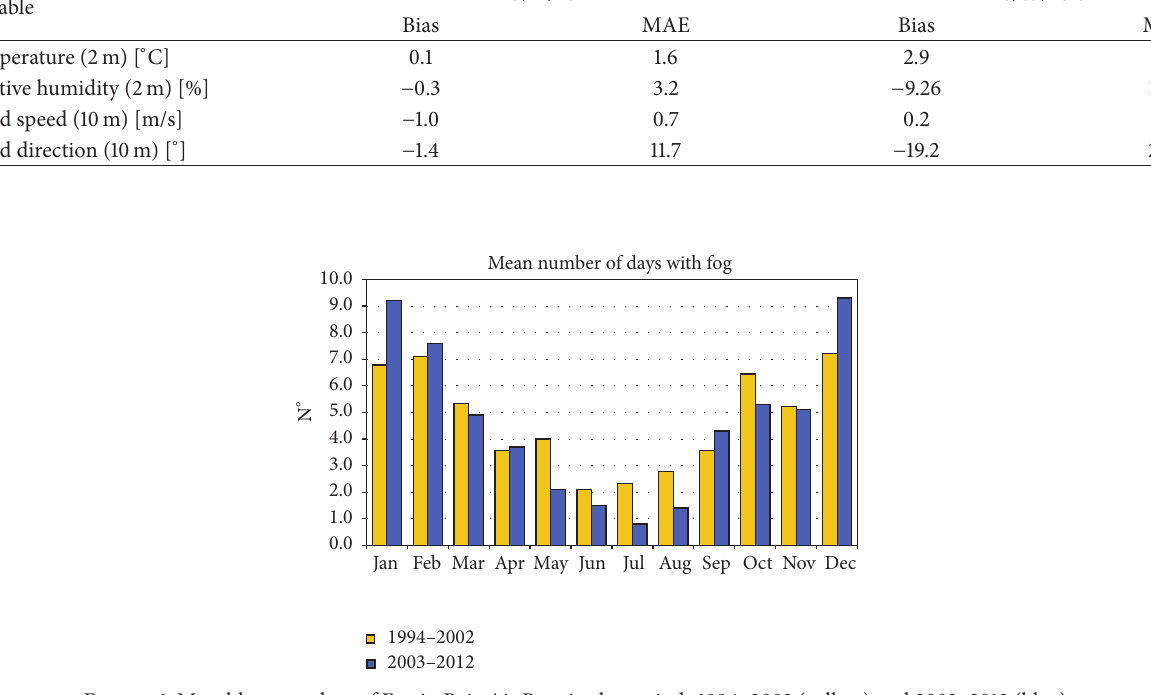
Table 4: Mean absolute error (MAE) from the comparison between observed data and its simulations (Cases II and V). Variable